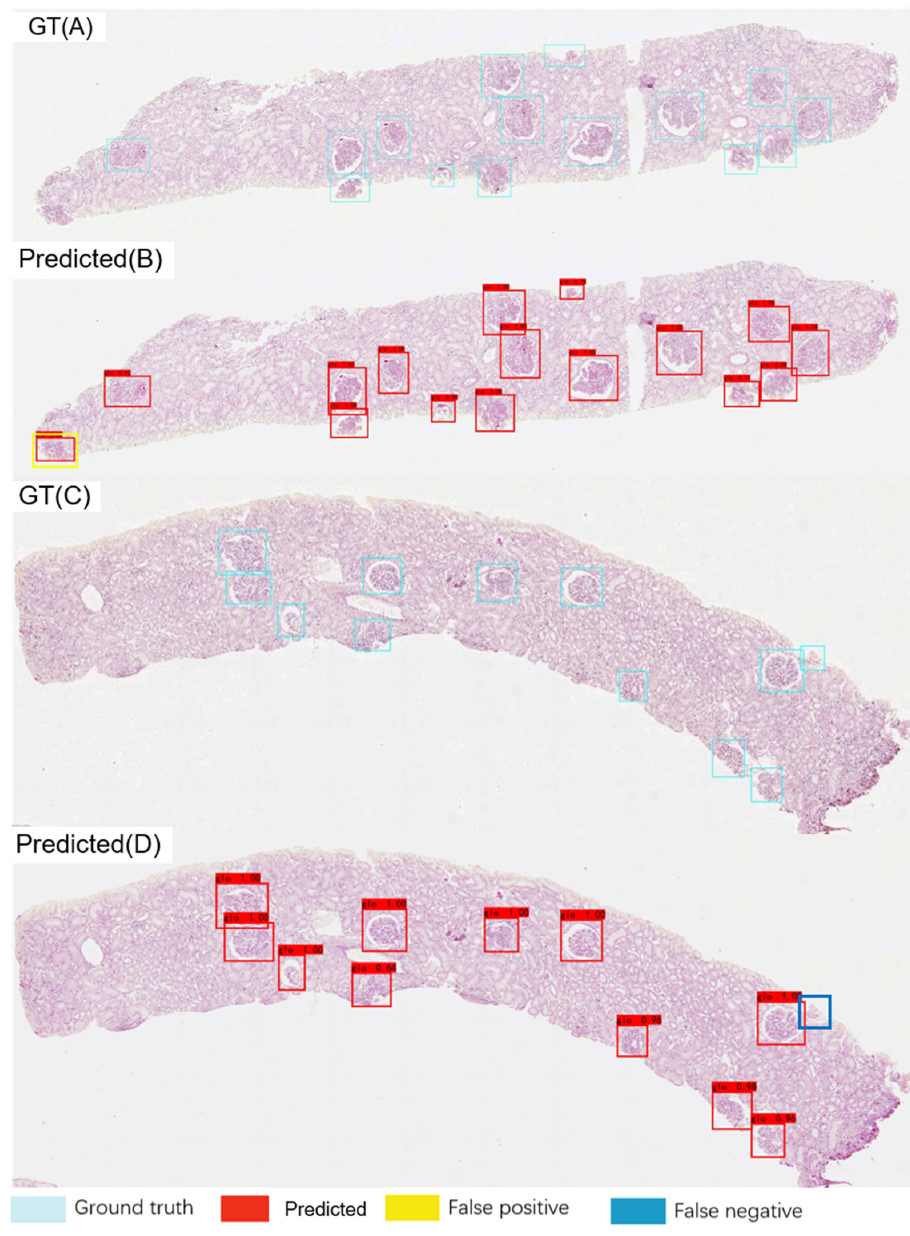
Figure 2. Ground truth (GT) and predicted glomerulus locations in low-resolution images. GT ( A ) and predicted ( B ) results for the same low-resolution image. The yellow box indicates a false positive result. GT ( C ) and predicted ( D ) results for another low-resolution image. The dark blue box indicates a false negative finding.